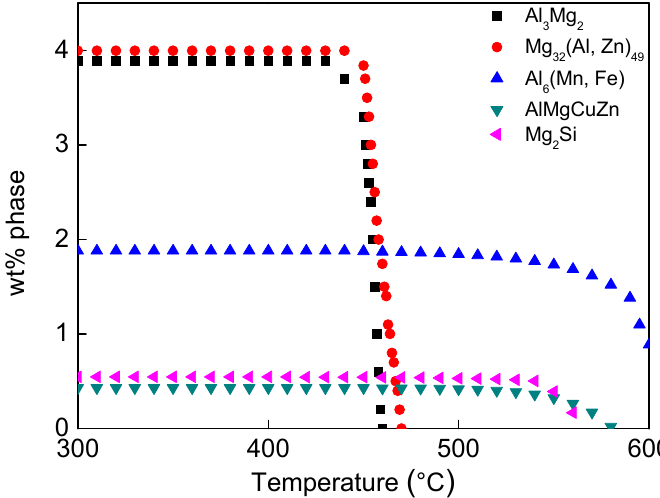
Figure 2. JMatPro simulation analyzing the second phase formation.